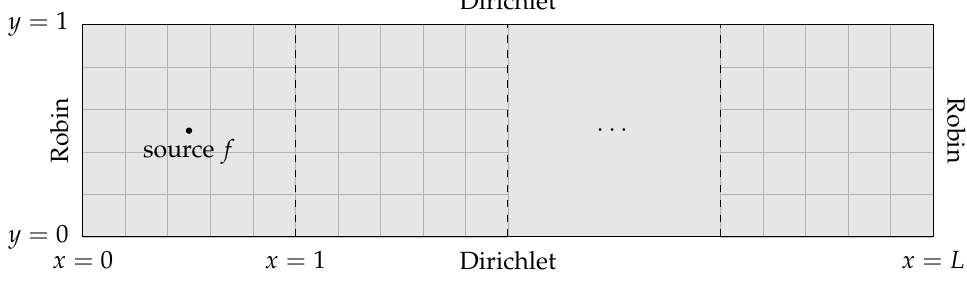
Figure 5. Schematic of the growing 2D wave guide model problem used in a weak scaling test on N = 25 L fixed size subdomains, with the underlying non-overlapping subdomains shown in